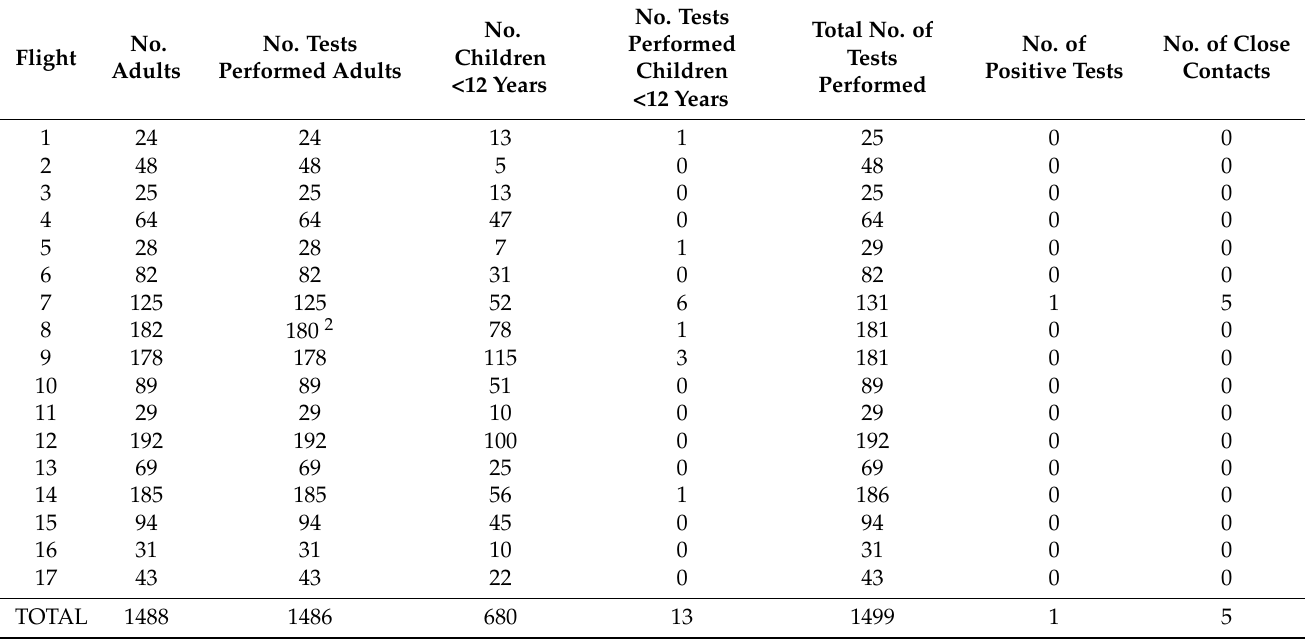
Table 2. Information on tests performed, number of positives and close contacts